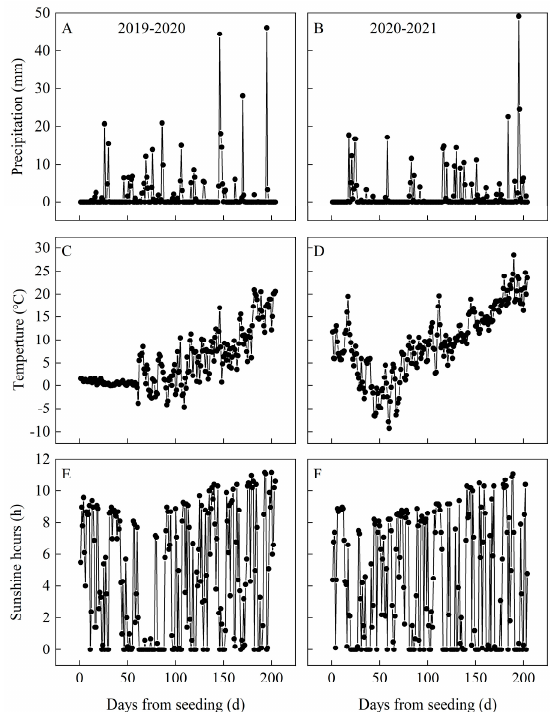
Figure 1. Precipitation ( A , B ), temperature ( C , D ), and sunshine hours ( E , F ) during the wheat − growing